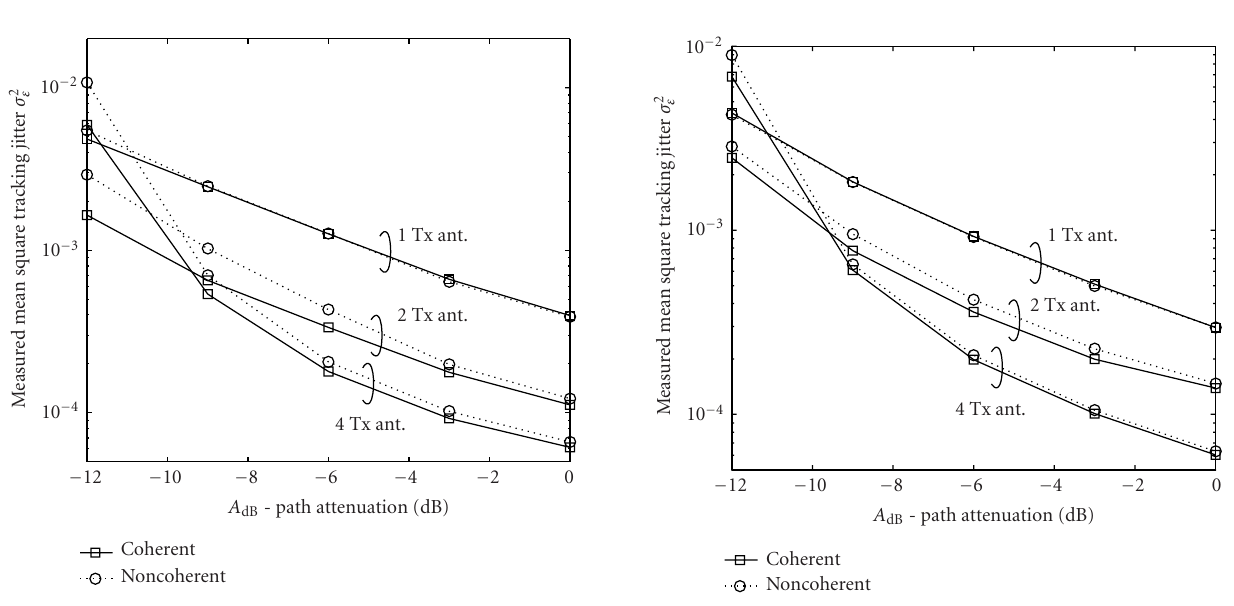
Figure 9: DLL performance-vehicular (50kph fading). Figure 10: DLL performance-vehicular (120kph